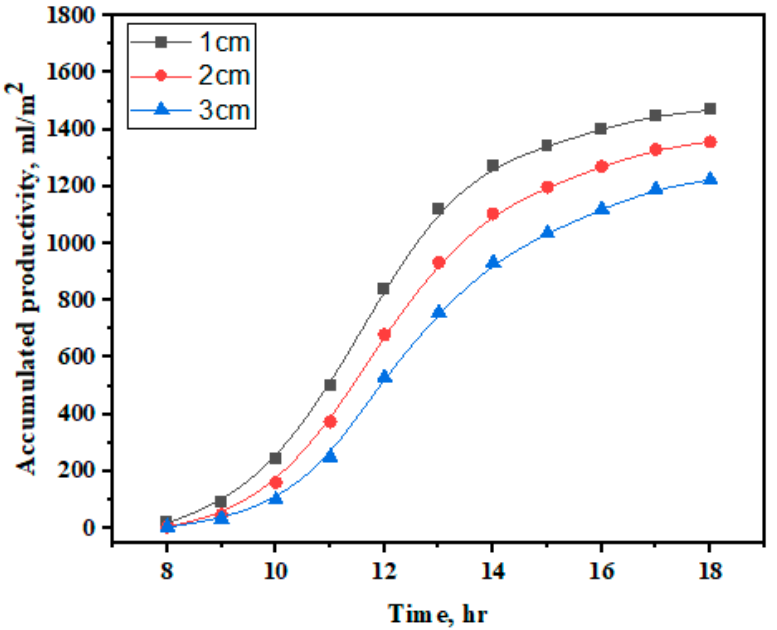
Figure 12. Accumulated water productivity with respect to time from the three considered cases of the still.